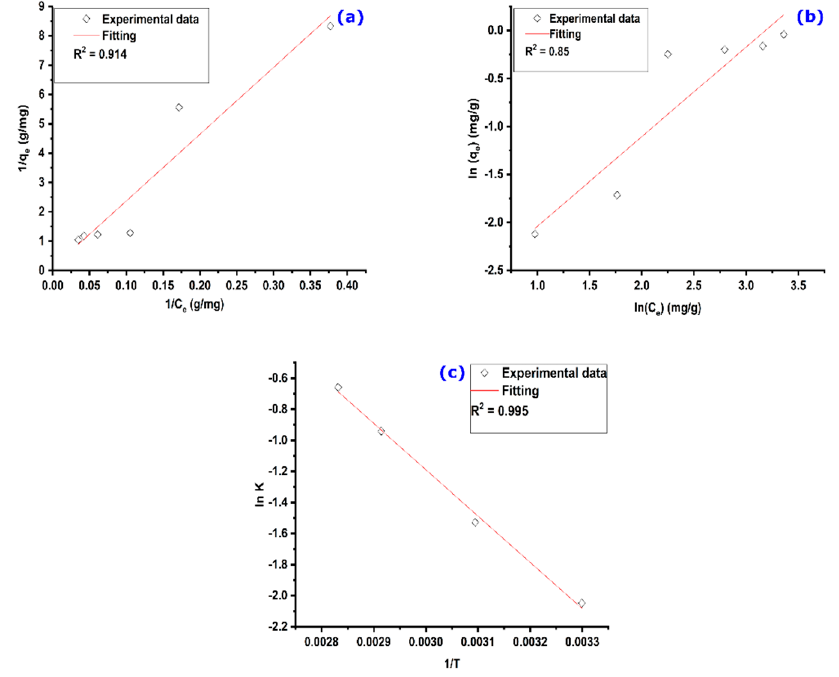
Figure 8. ( a ) Langmuir and ( b ) Freundlich isotherm models, and ( c ) K vs. 1/T for MO adsorption on AS. Experimental conditions: C 0 = Variable, m = 100 mg, V = 25 mL, T = 25 ◦ C, pH = 6.